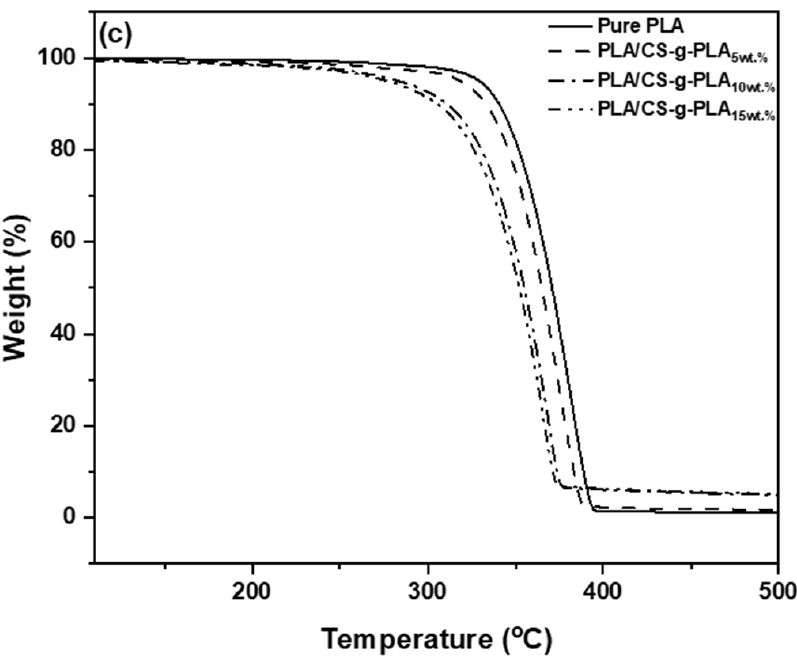
Figure 6. TGA curves of ( a ) PLA, CS, and CS-g-PLA; ( b , c ) PLA/CS and PLA/CS-g-PLA composite scaffolds at various CS and CS-g-PLA contents, respectively.